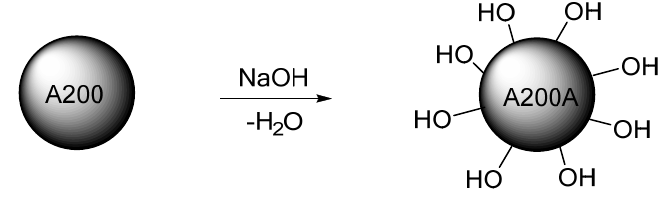
Figure 2. Activation of the fumed silica NPs.